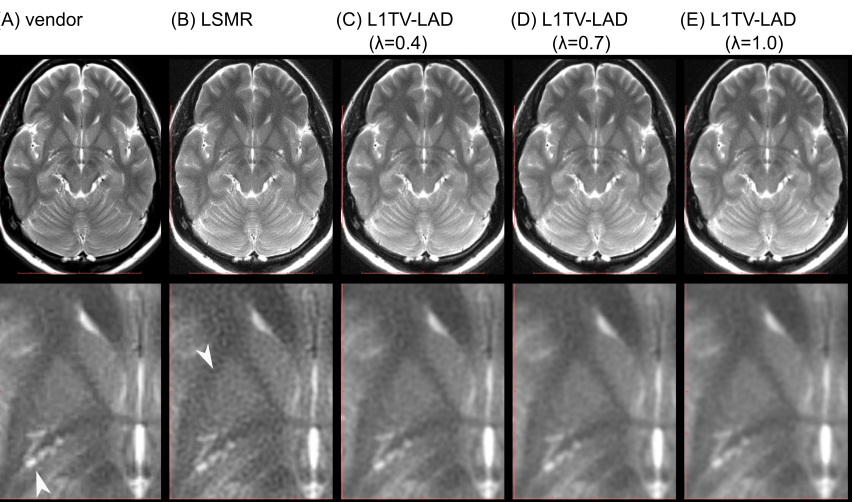
Figure 5. DICOM images for evaluation by radiologists. ( A ) is the vendor-provided image. ( B ) is the LSMR reconstruction. ( C – E ) are L1TV-LAD reconstructed images with λ = 0.4, 0.7, and 1.0, respectively. The vendor-provided image shows some zig-zag appearance (white arrow head). The LSMR reconstruction causes a higher level of noise (white arrow head). The vendor-provided image and least-squares reconstruction have some signs of the Gibbs artifact near the skull inner table and the falx.